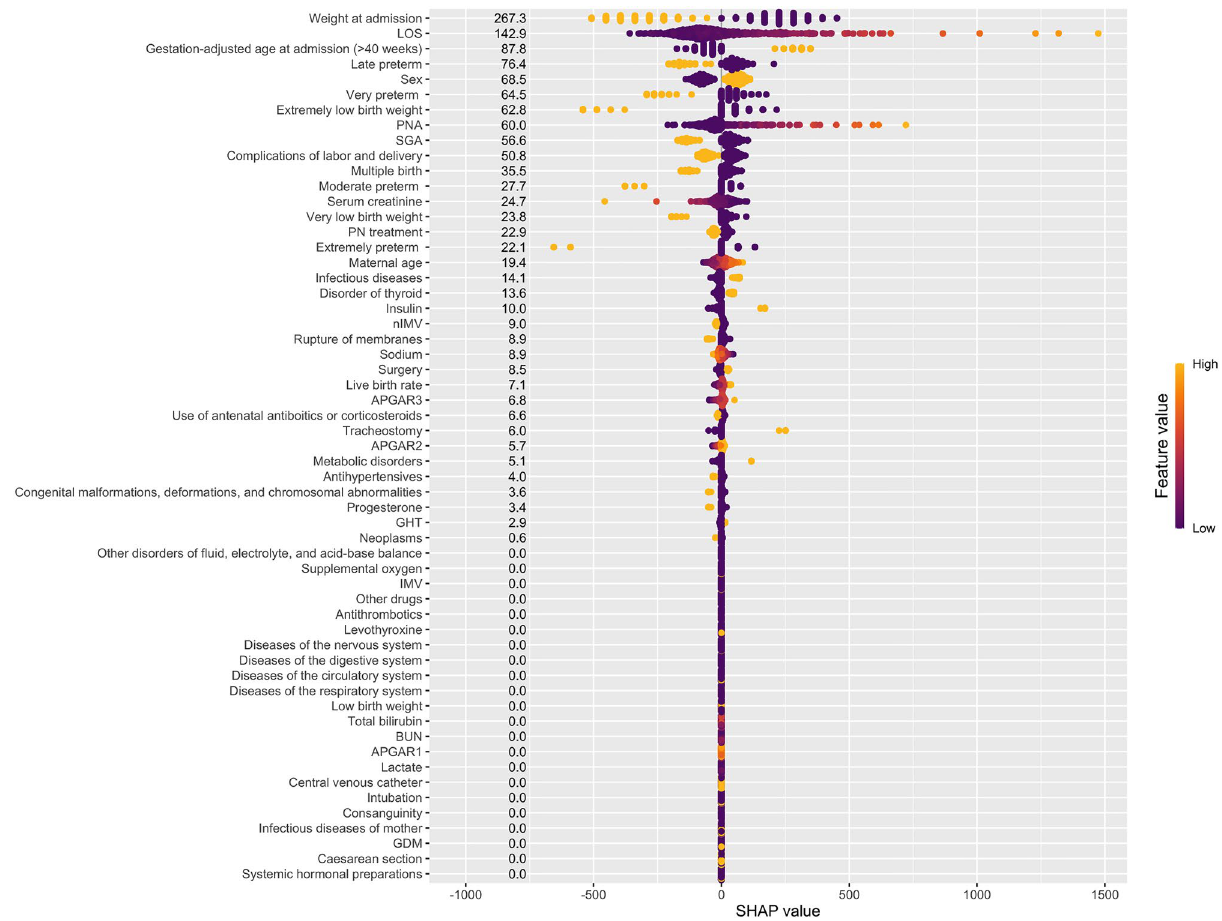
Figure 3. SHAP values for discharge weight